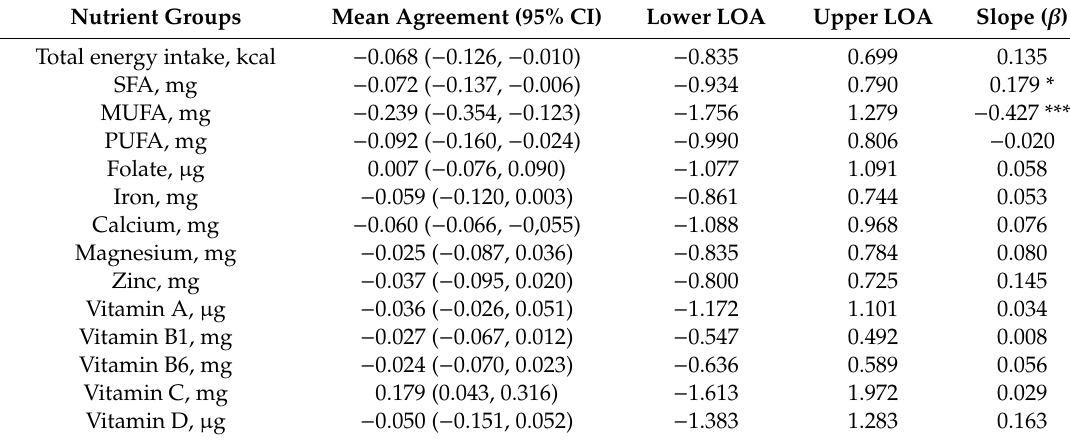
Figure 2. Bland–Altman plots of individual di ff erences in nutrient intakes (total energy intake, saturated fatty acids, monounsaturated fatty acids and folate) between the web-FFQ and print-FFQ against their averages; the upper and lower 95% limits of agreement (dashed lines), mean agreement (solid line) and regression slope (blue dashed line) are indicated. Table 4. Mean agreement and limits of agreement between nutrient intakes estimated by the web-FFQ and the print-FFQ.